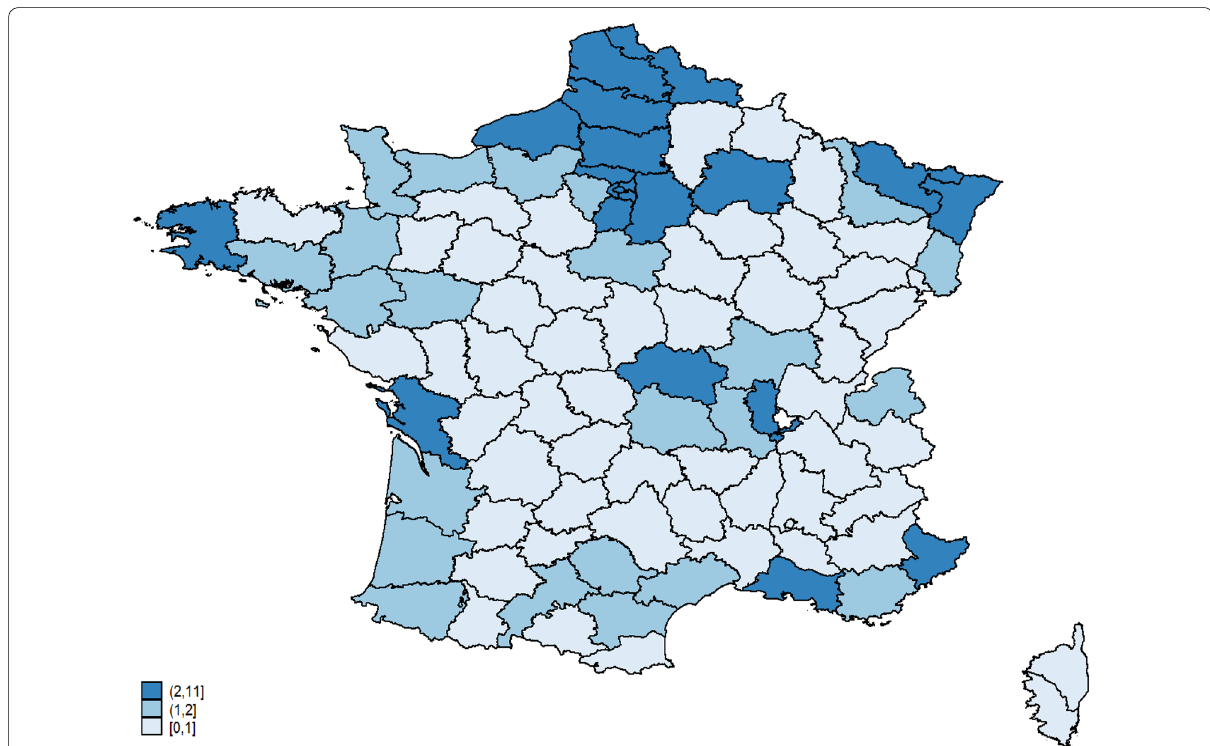
Fig. 1 Distribution of the 180 surveyed ICUs in continental